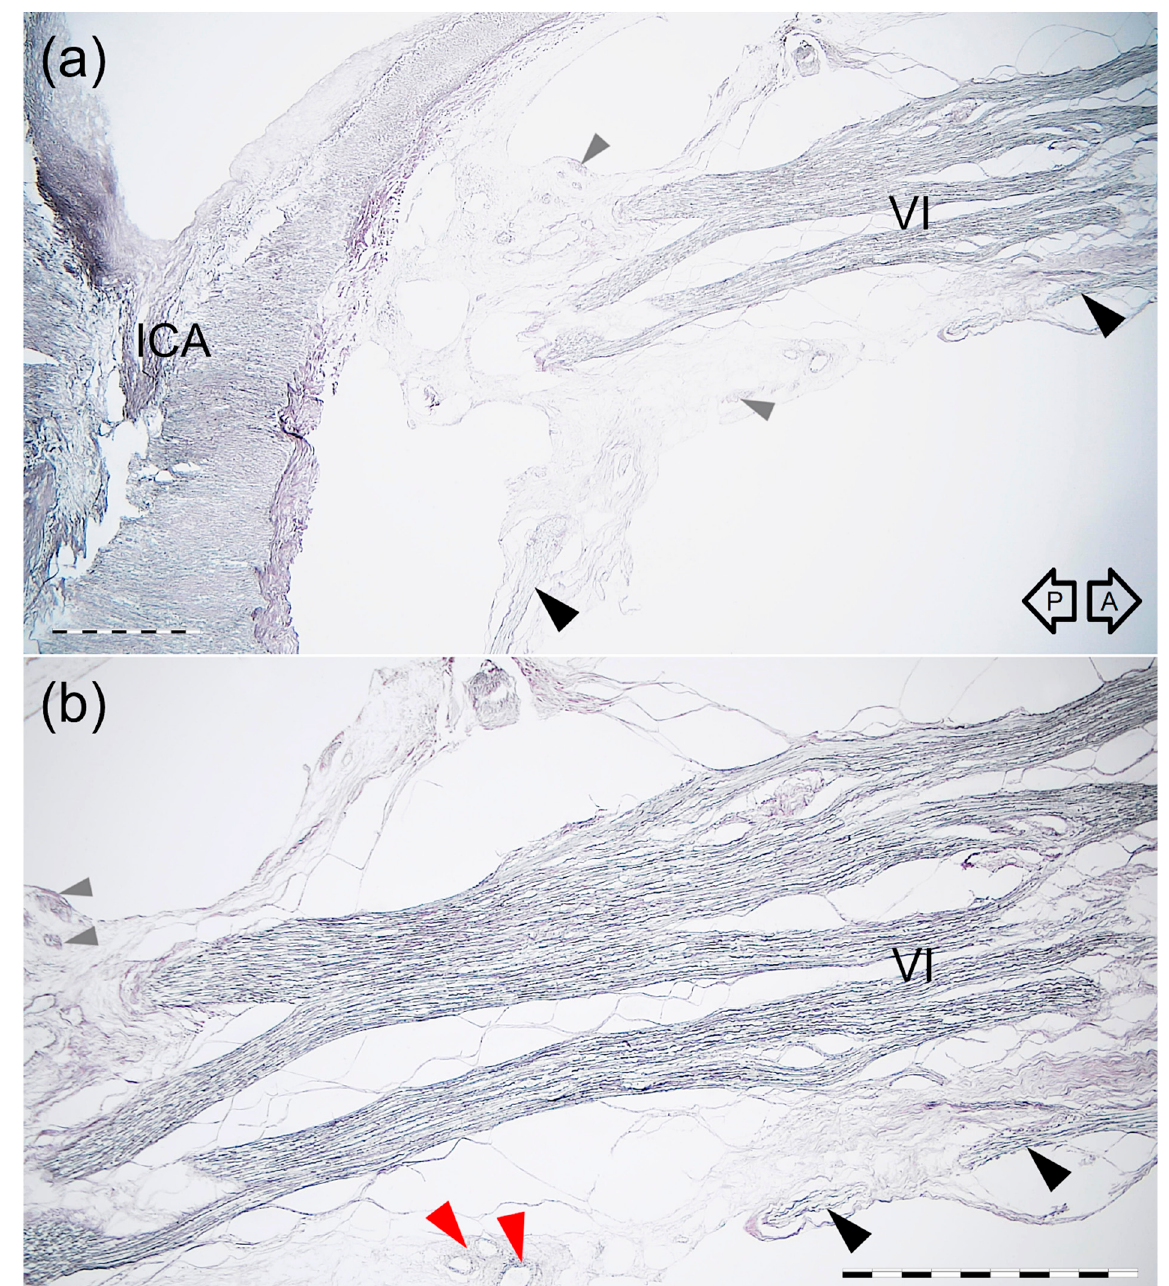
Figure 8. Histology of the “pseudobranching” of the AN. Longitudinal section parallel to the nerve’s long axis. Silver staining according to Gordon and Sweet’s method. ( a ) Panoramic view of the nerve seen using a 2 × objective lens. The black arrowheads indicate the anterior bundle of sympathetic fibers which join the inferior surface of the AN. Gray arrowheads indicate cross-sections of the delicate bundles derived from the ICP near the AN. ICA—internal carotid artery. ( b ) Magnification of the specimen presented in figure ( a ) seen under 4 × objective lens. The AN (VI) “pseudobranching” shows a plexiform appearance with interconnections between the fascicles. The anterior bundle of the ICP (black arrowhead) is exposed on the AN’s inferior surface. The red arrowhead shows a group of small blood vessels. The black arrows indicate anterior (A) and posterior (P) directions. Scale bar corresponds to 1 mm.